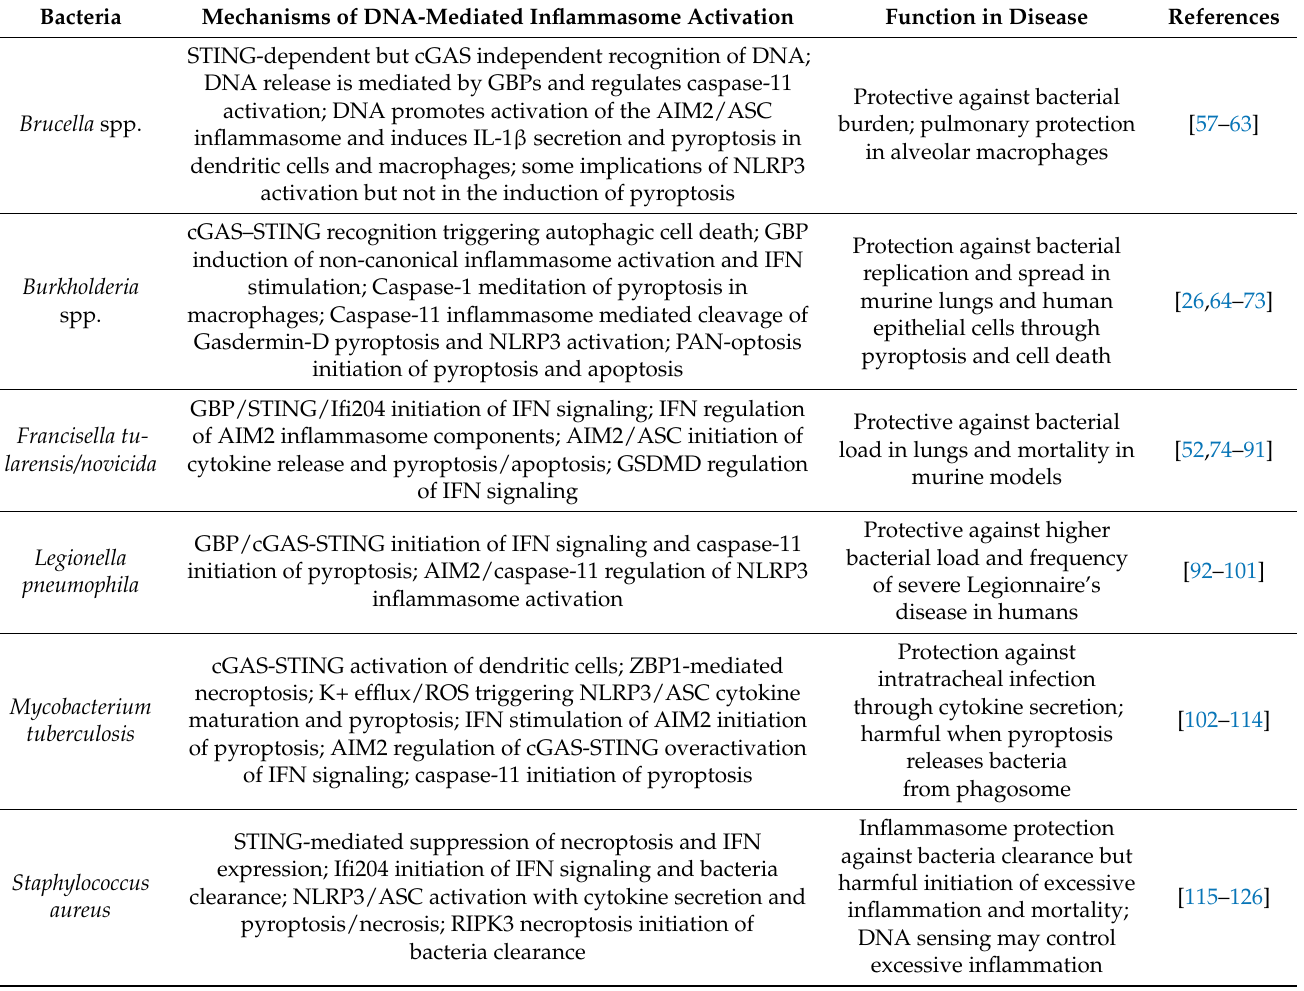
Table 1. Mechanisms of inflammasome recognition of bacterial DNA associated with respiratory pathogens. Mechanisms of DNA-Mediated Inflammasome Activation Function in